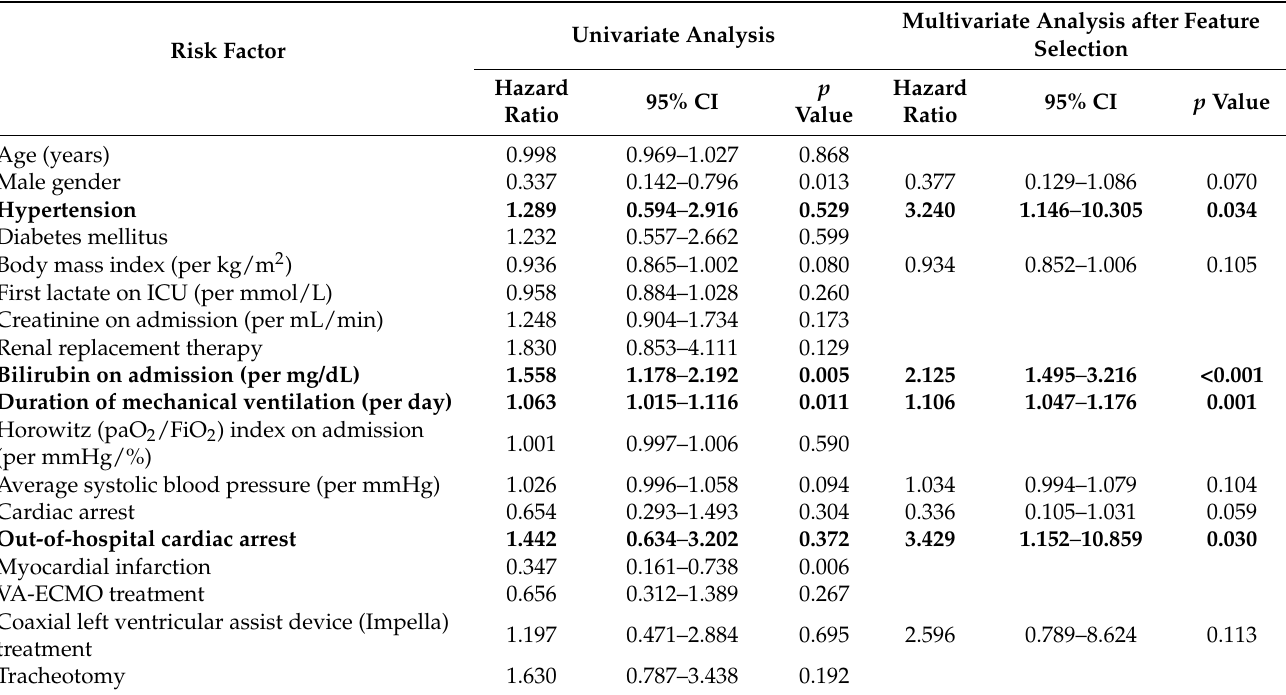
Table 4. Univariate and multivariate binary regression model for the prediction of HSV occurrence. Multivariate Analysis after Univariate Analysis Risk Factor